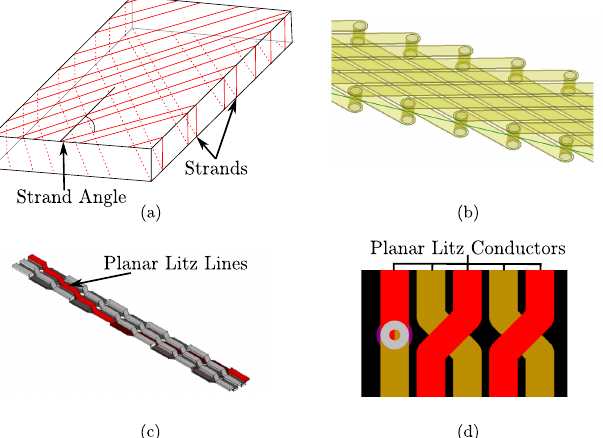
Figure 20. PCB-based Litzing involves winding conductors in a specific pattern on a printed circuit board. This provides a higher level of electromagnetic shielding and reduces the AC resistance of the conductor. This effect is more pronounced at higher frequencies, resulting in lower AC